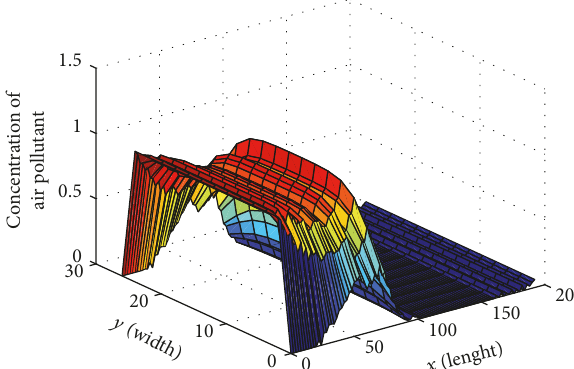
Figure 13: Surface plot of concentration of air pollutant levels for 𝑅 = 0.0 01sin (𝑥𝑡) sec −1 .